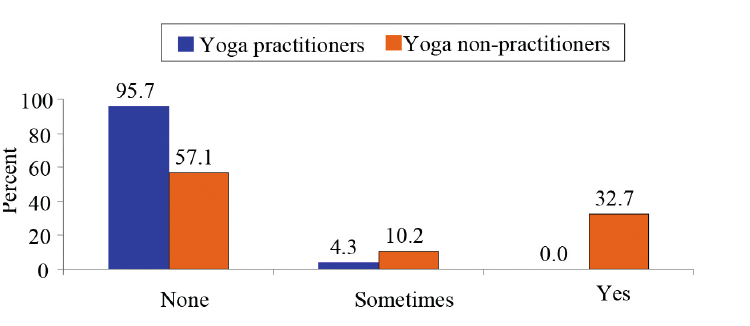
Figure 8. Pattern of smoking in the group of men yoga practitioners and non- practitioners